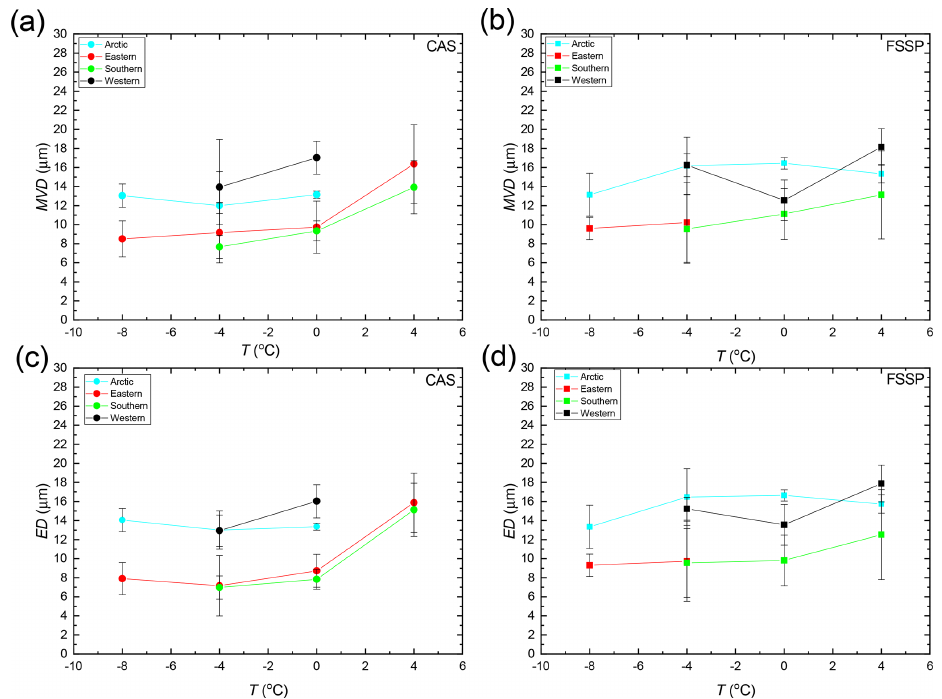
Figure 9. Hourly averages of median volume diameter (MVD) and effective diameter (ED) values versus temperature for all PaCE campaigns measured by the cloud and aerosol spectrometer (CAS) and the forward-scattering spectrometer probe (FSSP) where the PES fraction was within one region > 80%. Solid lines were made to lead readers’